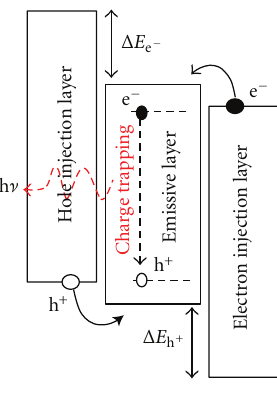
Figure 2: Excitons confinement in the emissive layer by the adjacent layer, Δ E e − is the energy barrier for electrons, and Δ E h + the energy barrier for the holes with charge